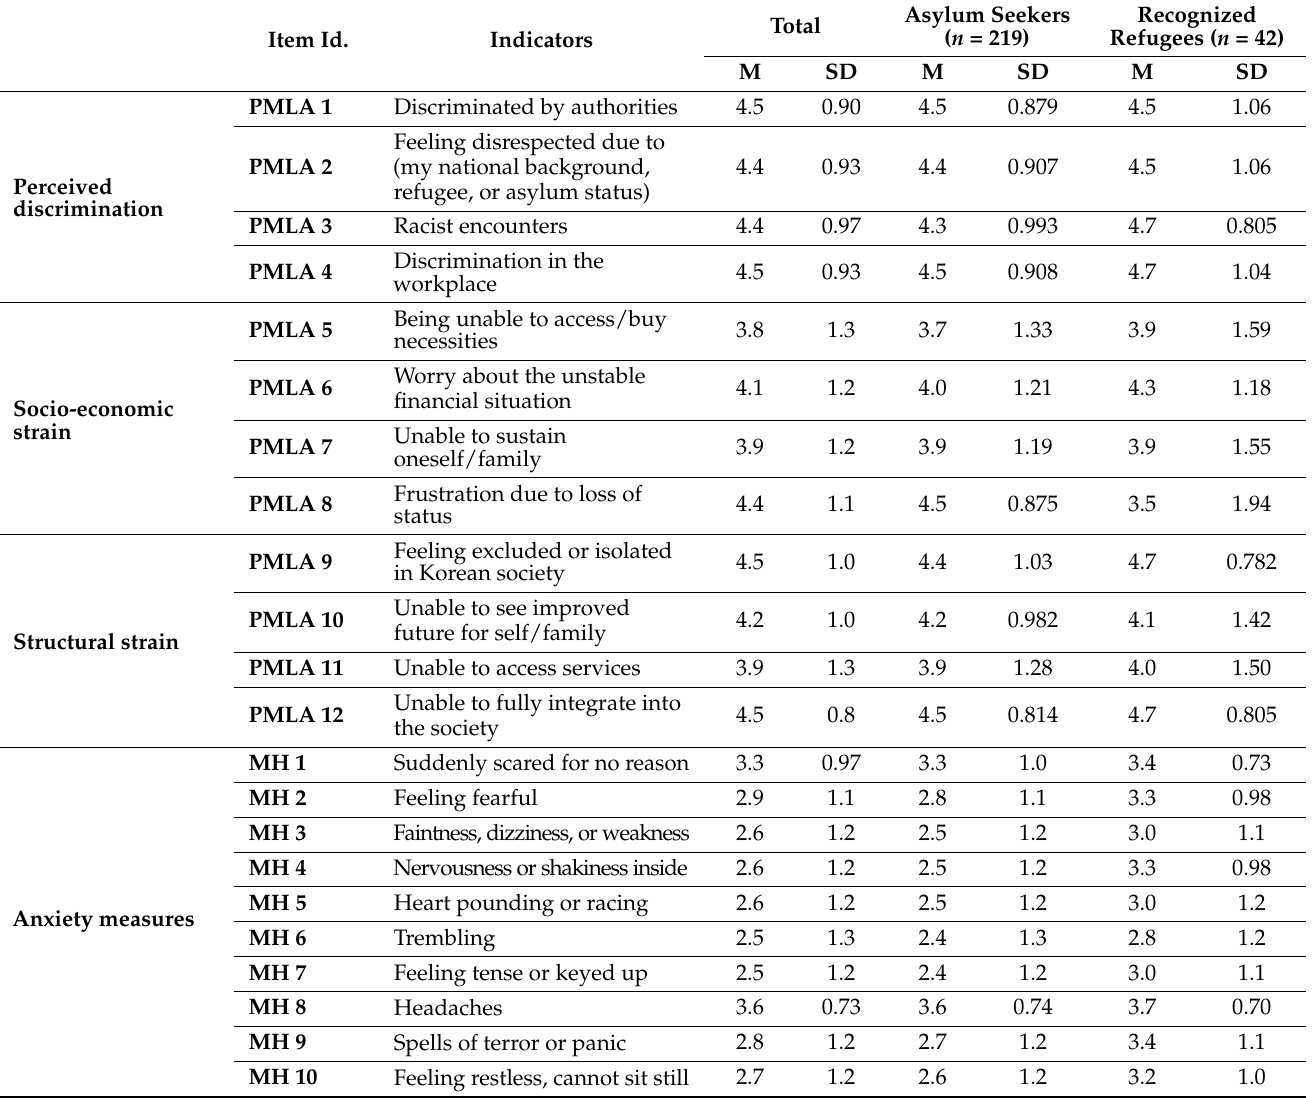
Table 3. Descriptive statistics of